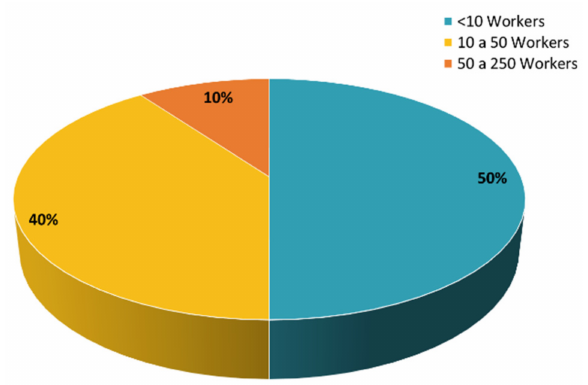
Figure 3. Distribution of surveyed companies by